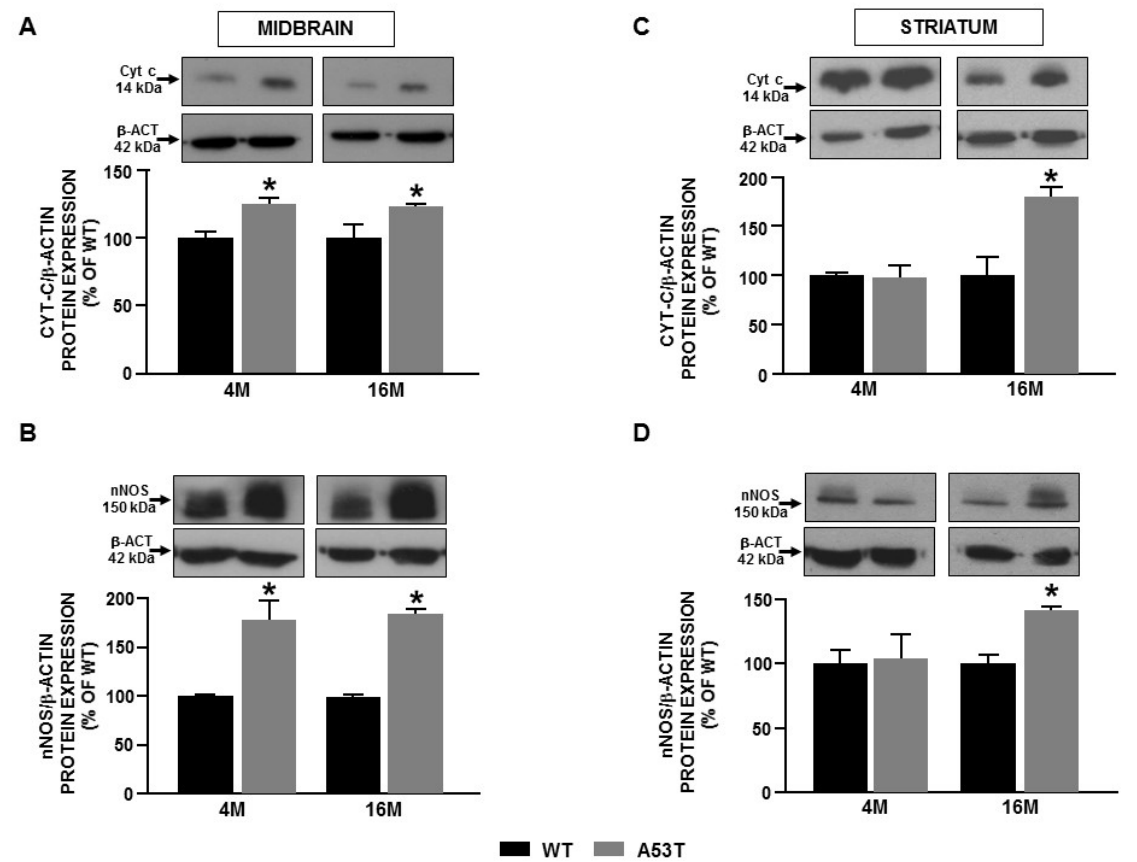
Figure 3. Cyt c and nNOS expression in midbrain and striatum obtained from 4 and 16-month-old A53T- α -syn and WT mice. Western blot analysis of Cyt c and nNOS protein expression in midbrain ( A , B ) and striatum ( C , D ) from A53T- α -syn and WT mice. Each bar represents the mean ± S.E.M. of the percentage of different experimental values obtained in three independent experimental sessions. * p < 0.05 compared to WT mice at the same